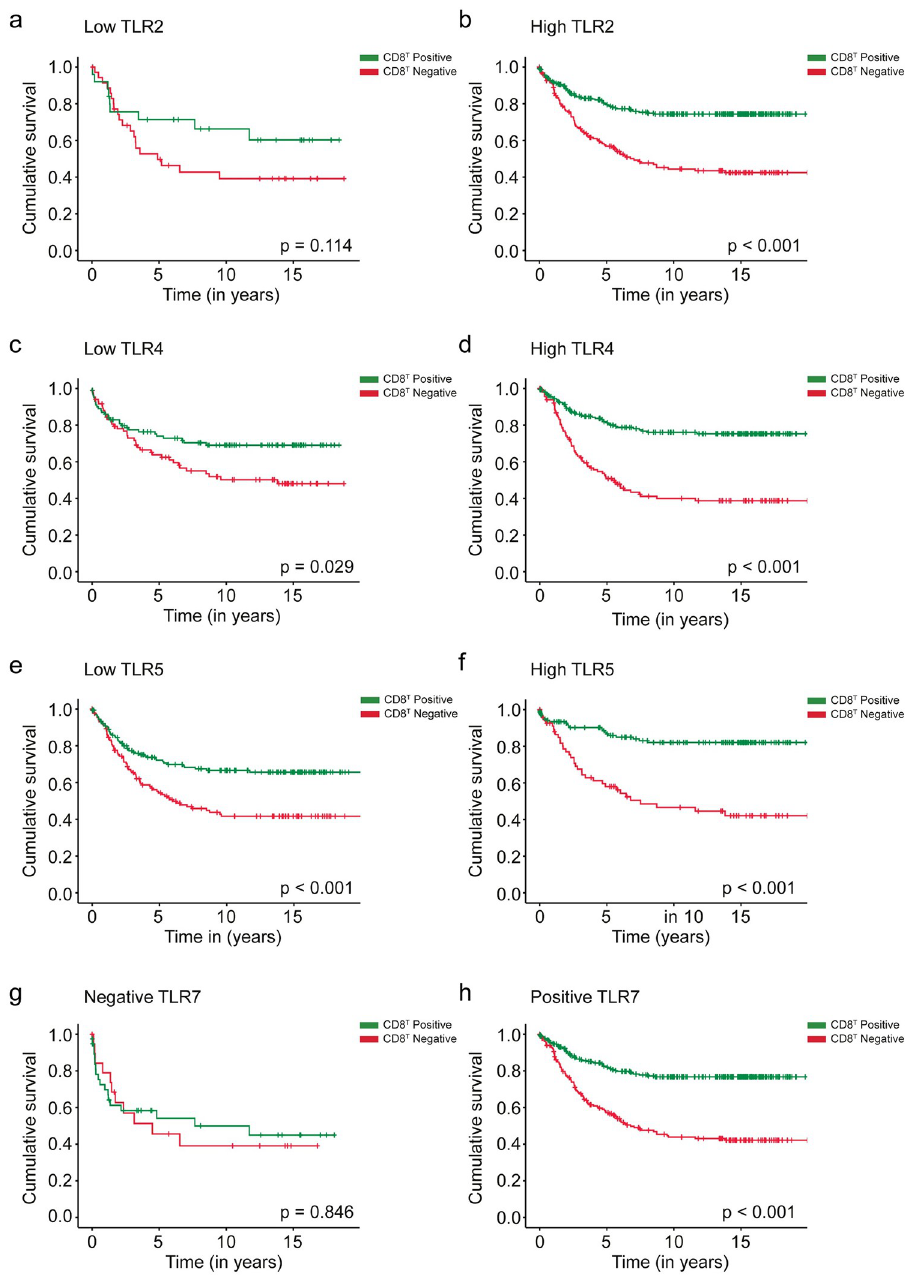
Fig 2. Disease-specific survival analysis of colorectal cancer patients using the Kaplan–Meier method. A negative versus positive intratumoral CD8 T expression among ( a ) low TLR2 expression patients, ( b ) high TLR2 expression patients, ( c ) low TLR4 expression patients, ( d ) high TLR4 expression patients, ( e ) low TLR5 expression patients, ( f ) high TLR5 expression patients, ( g ) TLR7-negative patients, and ( h ) TLR7-positive patients. The log-rank test was used.